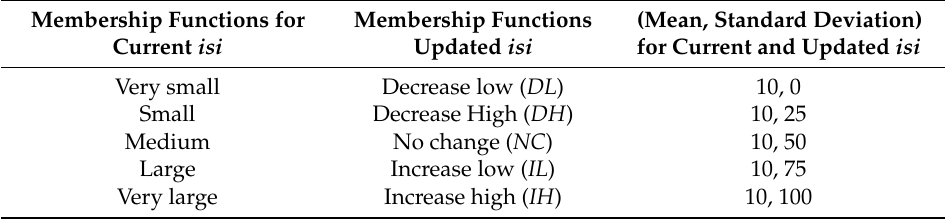
Table 2. Mean and standard deviation of the Gaussian fuzzy sets for the inter-sample interval difference and output updated inter-sample interval.